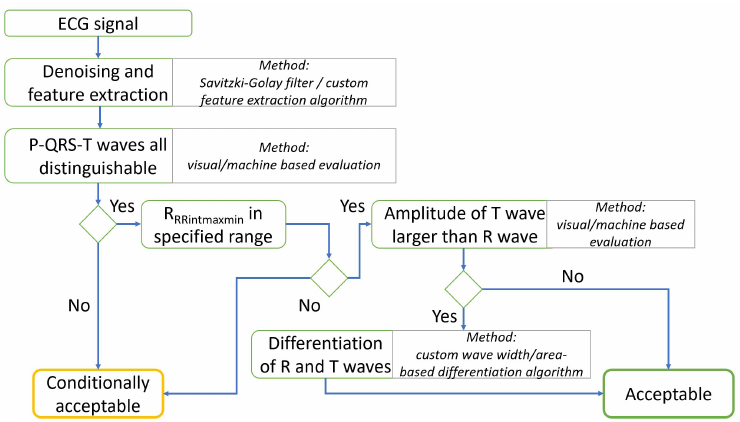
Figure 2. The applied decision tree for categorization of the signals of